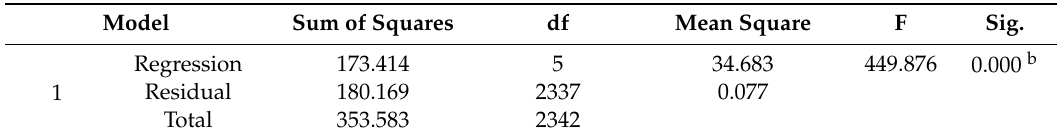
Table 5. Analysis of variance (ANOVA) a